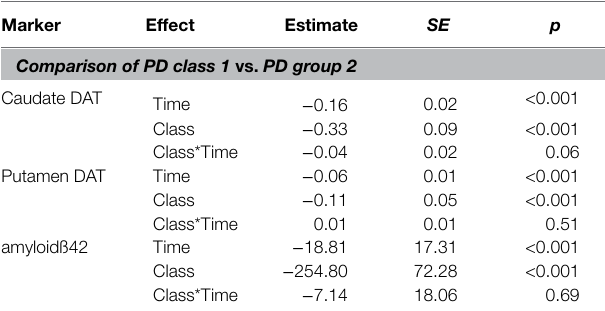
TABLE 5 | Linear mixed effects models for DAT and amyloidß42. Marker Effect Estimate SE p Comparison of PD class 1 vs. PD group 2 Caudate